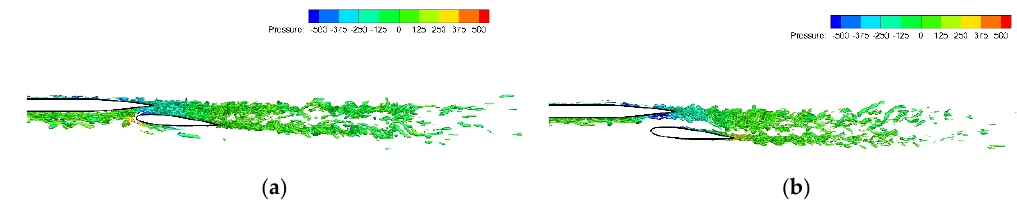
Figure 25. Iso-surfaces of Q-criterion(Q = 5000): ( a ) initial shape; ( b ) optimal shape.